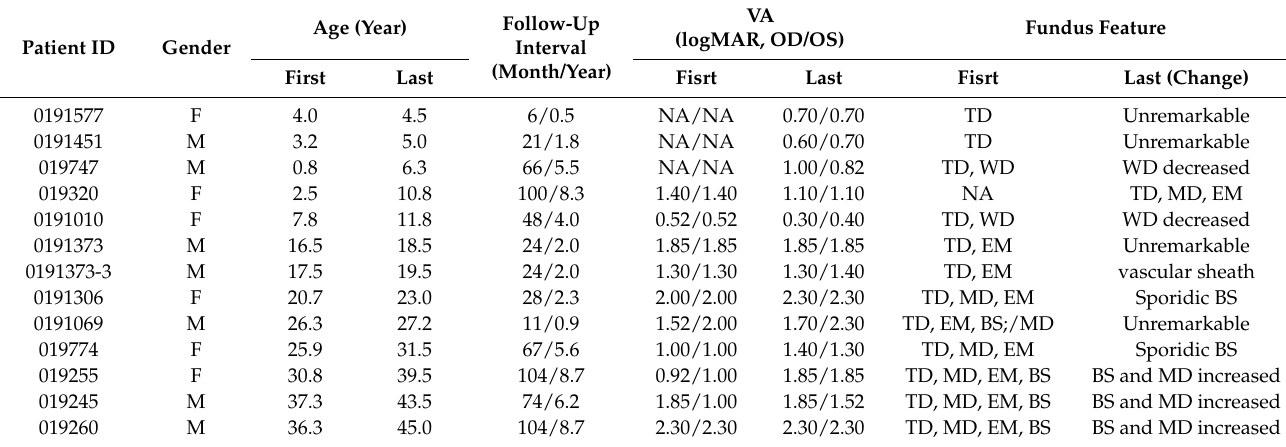
Table 2. The follow-up information and clinical features of patients with biallelic RPE65 variants in this study.